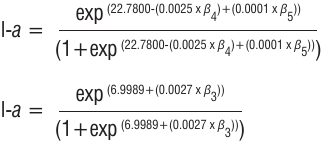
The results of the logistic regression as applied on April 2014, May 2015 and July 2016 Landsat 8 OLI images of the study area Image